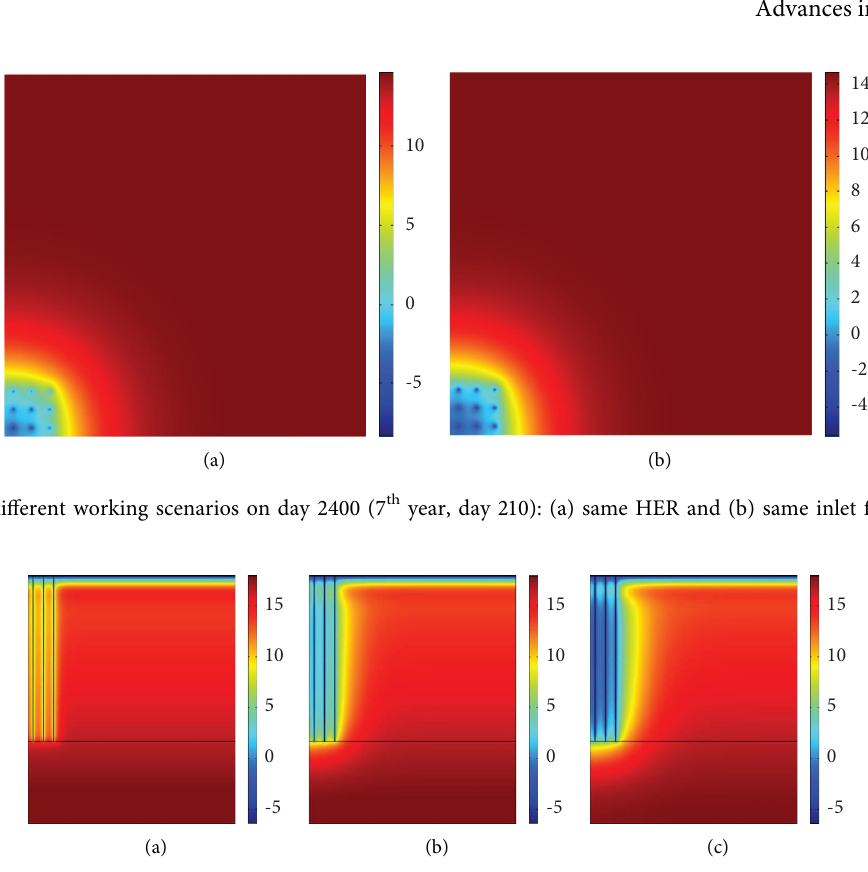
Figure 10: Ground temperature contour around the BHEs for the inlet temperature scenario after (a) t � 210 d (1 st year, day 210); (b) t � 1305d (4 th year, day 210); (c) t � 2400d (7 th year, day 210).